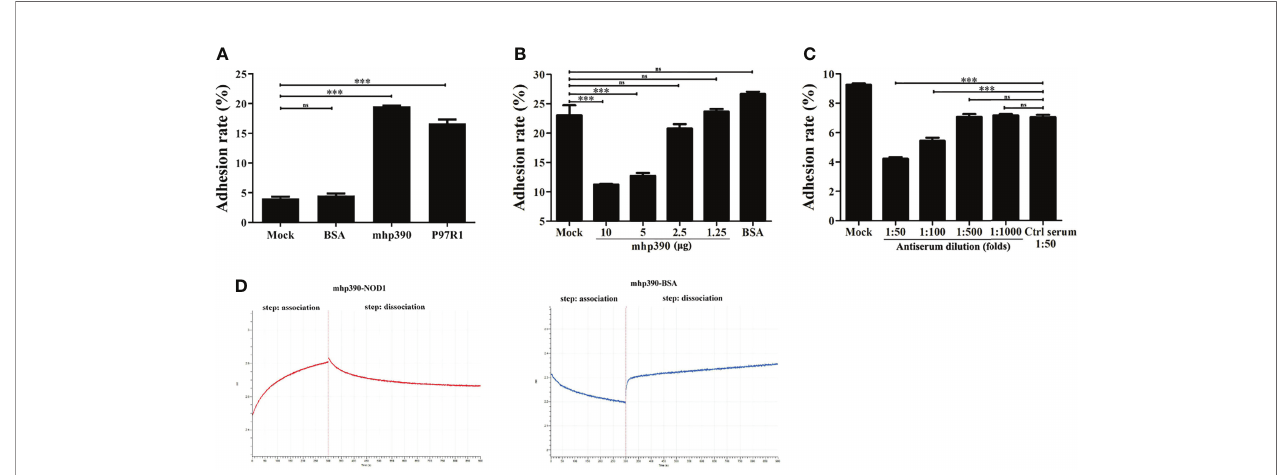
FIGURE 6 | mhp390 mediates M. hyopneumoniae adhesion to alveolar macrophages and interacts with NOD1. (A) Adhesion of rMhp390 to alveolar macrophages detected by fl ow cytometry. (B) The adhesion of M. hyopneumoniae to alveolar macrophages was inhibited by rMhp390. The cells were incubated with different concentrations of rMhp390 before infection. BSA (10 m g/mL) and 1 mL of RPMI 1640 alone were used as the negative and blank controls, respectively. (C) The adhesion of M. hyopneumoniae to alveolar macrophages was inhibited by anti-rMhp390 serum. M. hyopneumoniae was incubated with anti-rMhp390 serum diluted from 1:50 to 1:1000 before infection. The mixed negative serum (unimmunized rabbit serum, 1:50 dilution) was used as the negative control. *** P < 0.001 indicate statistically signi fi cant differences among different groups, and ns represents no difference. (D) Kinetic analysis of the af fi nity between mhp390 and NOD1 through bio-layer